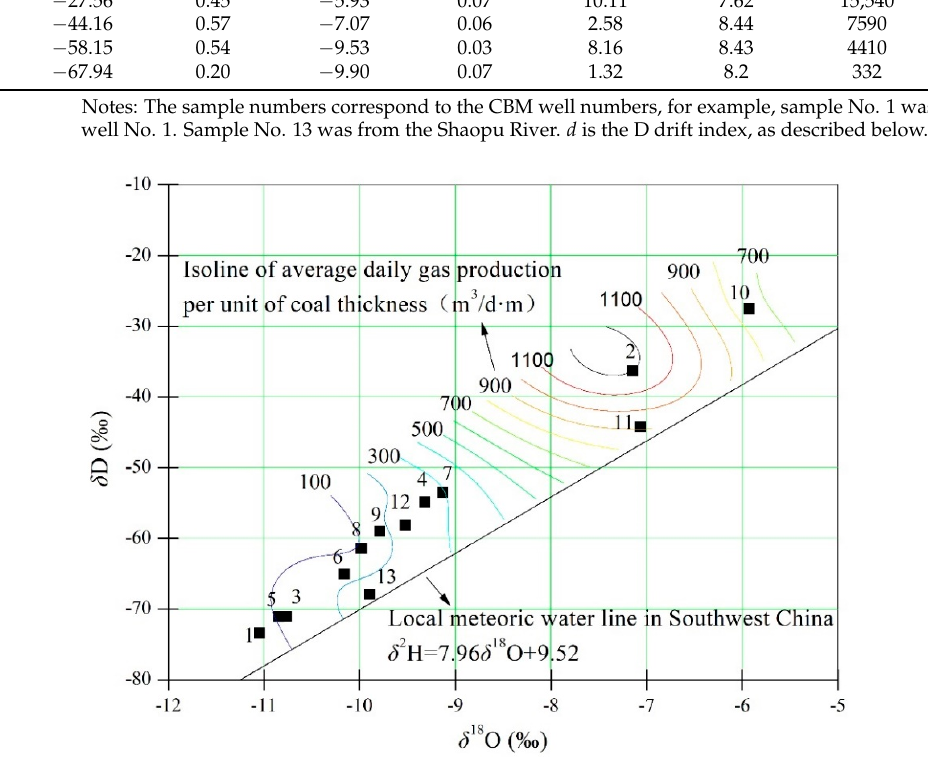
Figure 3. Relationship between the δ 18 O and δ D values of the water samples.